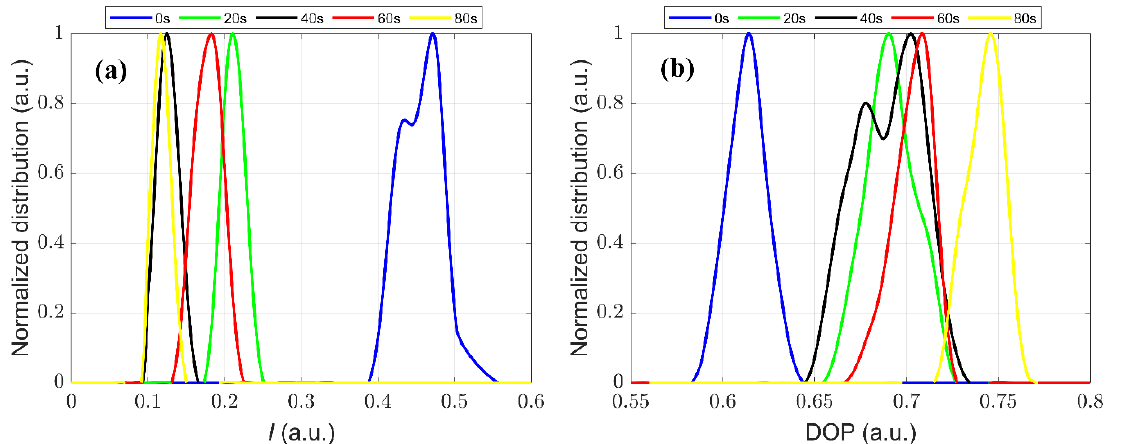
Figure 5. The distribution of ( a ) I ( b ) DOP for samples with different ST times.